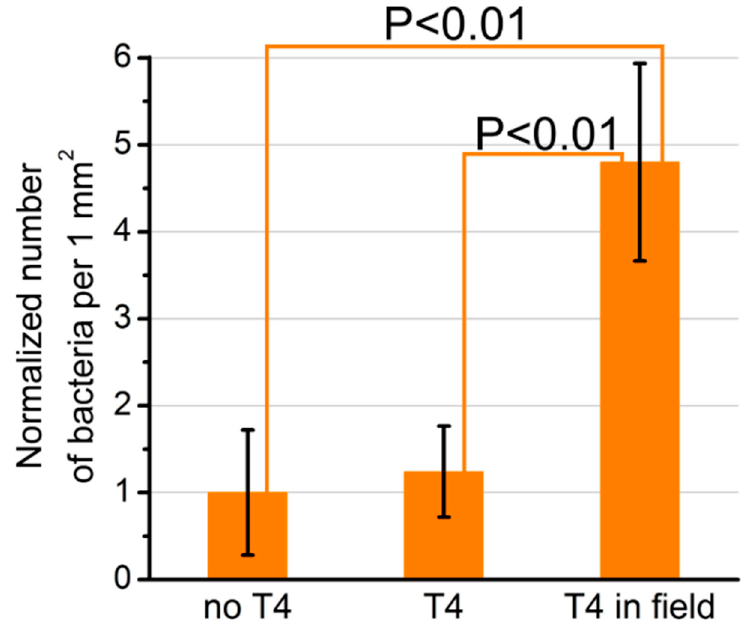
Figure 14. Conducting T4 bacteriophage immobilization in a constant external electric field enables a statistically significant higher phage density [120]. Reprinted from [120], Copyright 2016, with permission from Elsevier.